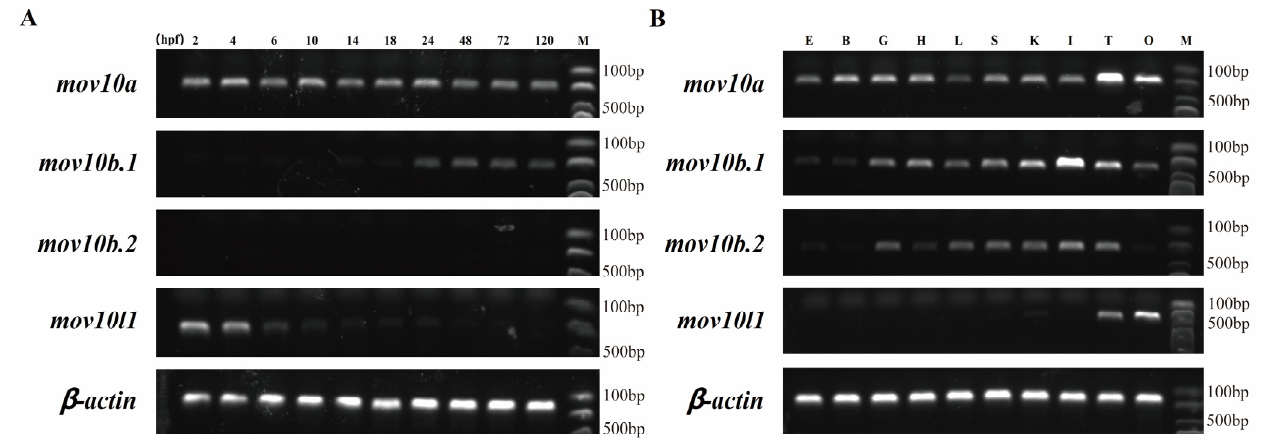
Figure 8. The Expression electrophoretogram of zebrafish mov10s and mov10l1 genes. The transcript expression level of each mov10s and mov10l1 gene was determined by RT-PCR in 10 embryonic development stages ( A ) and 10 tissues from six adult zebrafish ( B ). The number of PCR amplification cycles was 30. E, eye; B, brain; G, gills; H, heart; L, liver; S, spleen; K, kidney; I, intestine; T, testis; O, ovary; hpf: hour post fertilization; M, DNA Markers.